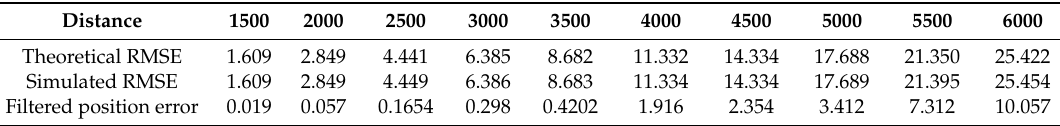
Table 4. Positioning result of Scenario 4.